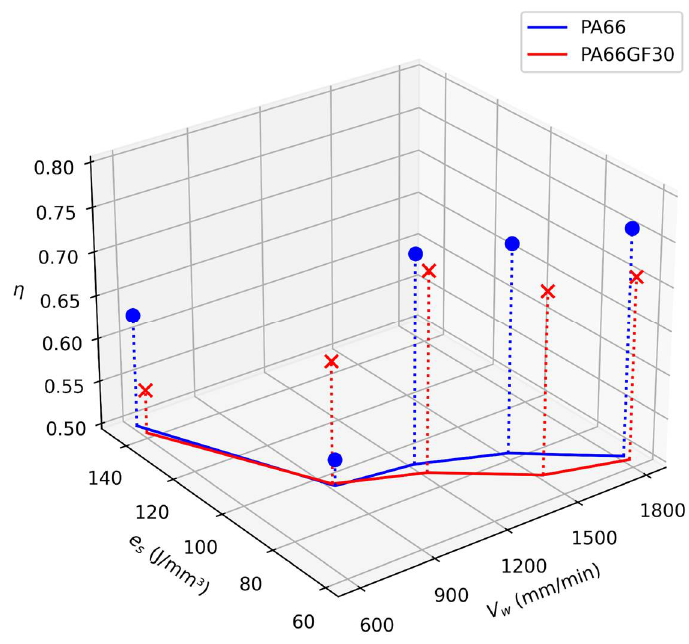
Figure 3. The plot of the specific energy e s , energy cutting partition η , and infeed speed v w . The energy cutting partition η quickly raised with a speed increase, starting from the initial value of 55%, and arriving at the maximum value of 75%. Since the temperature